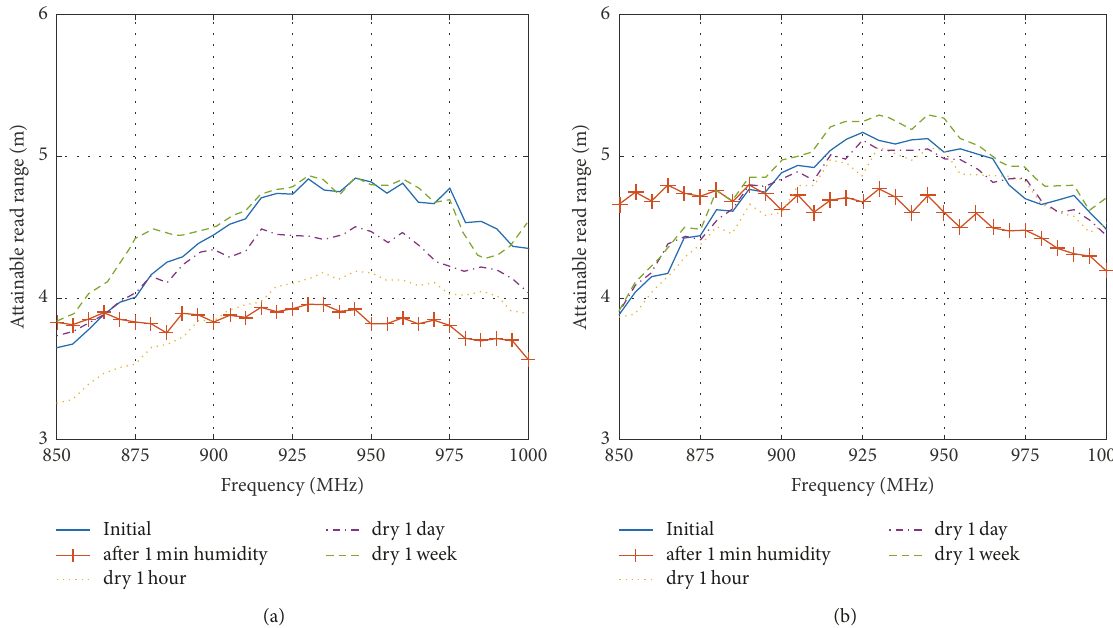
Figure 6: Read ranges of graphene RFID tags before and after high humidity conditions: (a) epoxy-glued IC attachment and (b) printed IC